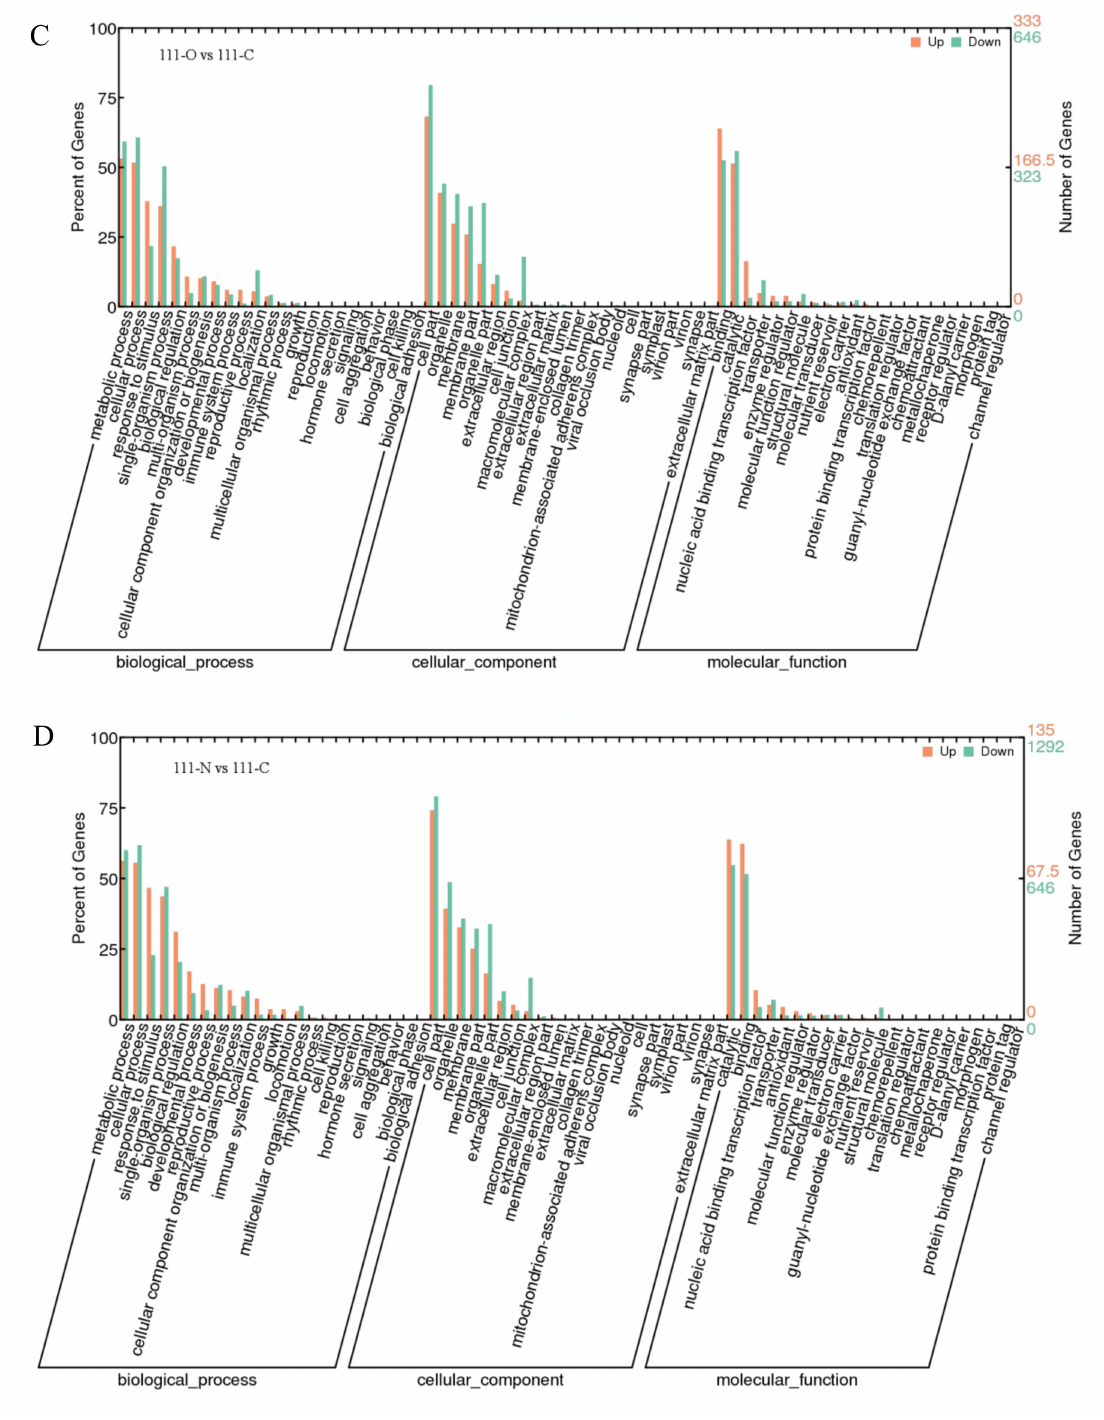
Figure 5. Gene ontology (GO) analysis of the DEGs among the ‘108’ and ‘111’ treatment groups. GO analysis of the DEGs between ( A ) oviposited and control leaves of ‘108,’ ( B ) neighboring and control leaves of ‘108,’ ( C ) oviposited and control leaves of ‘111,’ and ( D ) neighboring and control leaves of ‘111’. C, control; N, neighboring; O, oviposited; up, up-regulated genes; down, down-regulated